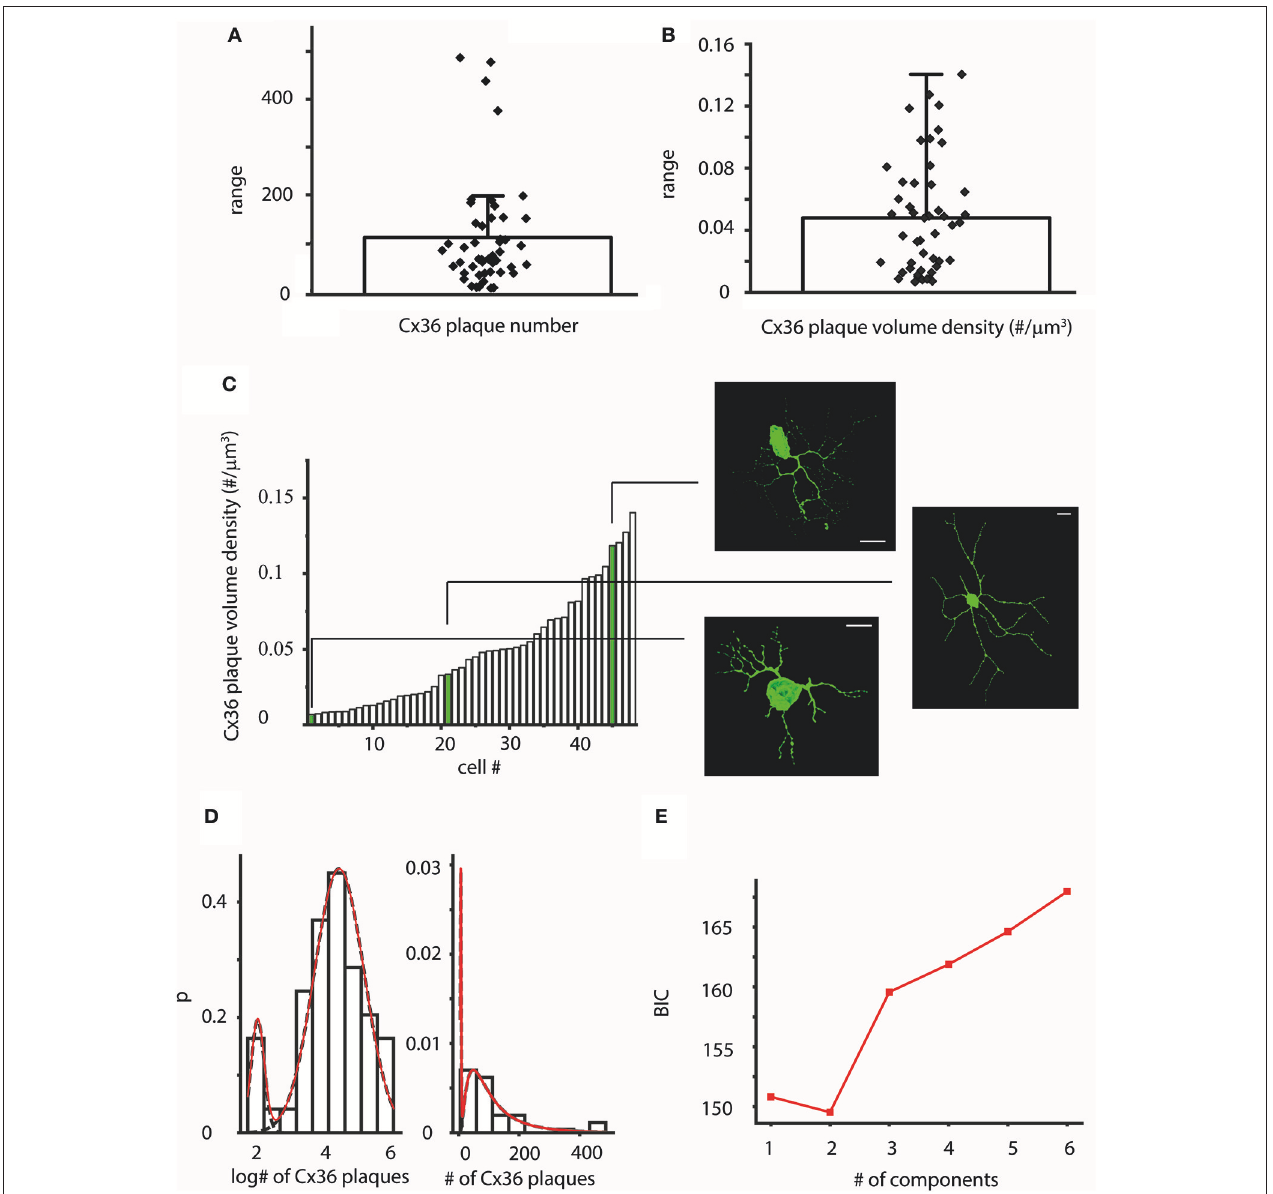
FIGURE 2 | Variations in Cx36 plaque number across the hRGC population. (A,B) Bar-overlap charts and scatterplot showing the average values (A) and density (B) of plaque numbers colocalized with LY labeled hRGC dendrites. Overlapping scatterplot (diamonds) represents individual number (A) and density (B) values for each examined cell. The wide range of plaque counts and densities are resulted by the heterogeneous nature of the sample. (C) After sorting volume density values (# of plaques/ µ m 3 ) in an ascending order the resultant histogram displays local plateaus, suggesting that several subgroups of cells with similar plaque densities exist in our dataset (see also Supplemental Figure 2 for length and surface density values). Snapshots of 3D reconstructed hRGCs corresponding to each of the subgroups are shown on the right (relevant density values are highlighted in green). (D,E) Forty-seven cells were clustered into two groups based on CX36 plaque numbers on dendritic surfaces. The two clusters were modeled with lognormal distributions (note the logarithmic scale), with mean plaque numbers 6.824 and 88.481; BIC minimum was determined as 2 components. Approximately 90% of the cells belonged to the cluster with the higher mean Cx36 plaque number. Scale bars: 25mm.